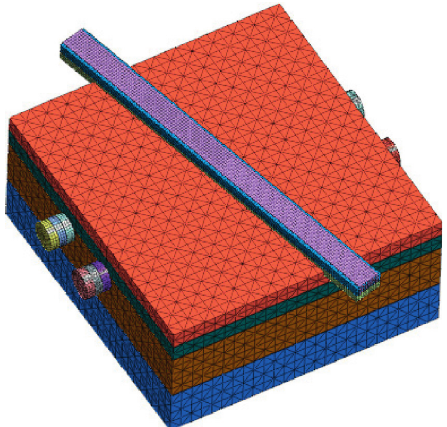
Figure 5: Numerical simulation